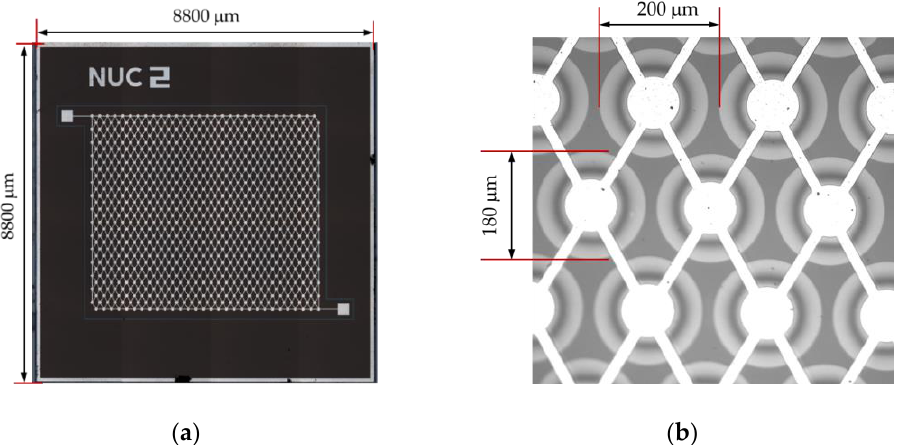
Figure 2. A microscope photograph of the fabricated CMUT device die. ( a ) Top view of the fabricated CMUT device with 900 cells; ( b ) magnified view of cells.